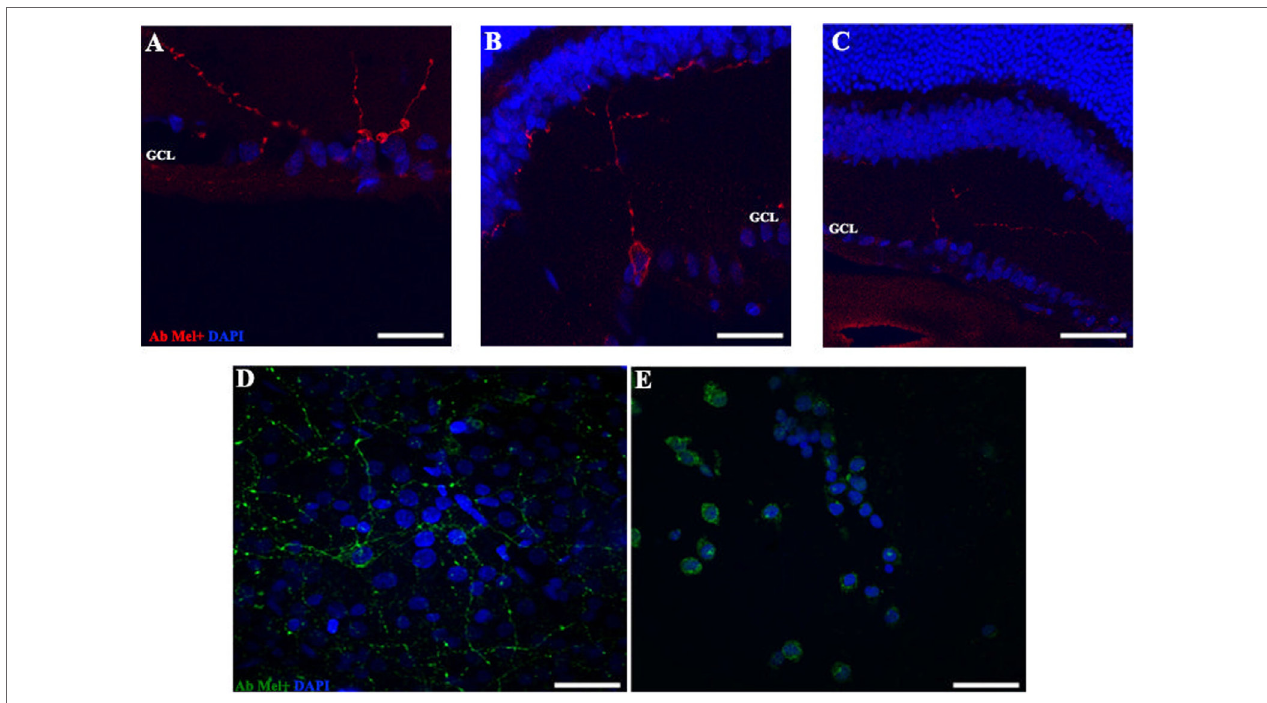
FigUre 4 | OPN4 expression in retinal cuts and whole mount in animals exposed to light: details of retinas maintained in dark during 4 days (a) ; LD 8 days (B) or 8 days at LL (c) at higher magnification than in Figure 3 . Red: OPN4 antibody staining; blue: nuclear DAPI staining. Scale bar indicates 10 µm. (D,e) stained retinal whole mount with retinal ganglion cell side up of retina from animals maintained in LD (D) and LL 8 days (e) showing a differential distribution of OPN4 labeling. Blue: DAPI, green: OPN4 antibody. The images are representative of three different experiments per treatment. Scale bar indicates 30